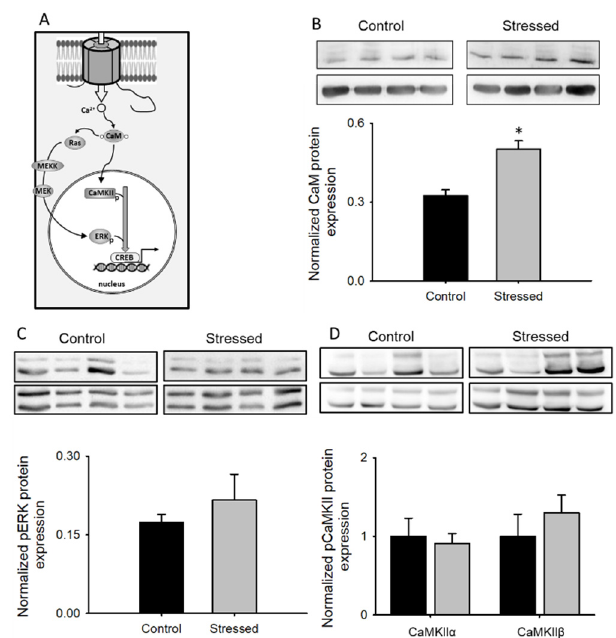
Figure 6. CaM-dependent signaling in CRS-subjected animals: ( A ) Schematic diagram depicting the signaling pathway studied in this figure. ( B ) Bar graph of CaM protein expression from whole hippocampus lysates normalized to α -tubulin ( n = 8), in the upper part, a representative immunoblot showing CaM and α -tubulin protein expression is shown. Bar graph of pERK ( C , n = 8), pCaMKII ( D , n = 8) expression from whole hippocampus lysates normalized to the total respective protein. Representative Western blots for pERK, pCaMKII, as well as total ERK and CaMKII are shown in the upper part of each bar graph. Bar graphs are mean ± SEM; black bars are control animals, and gray bars correspond to CRS-subjected animals * p value < 0.05.